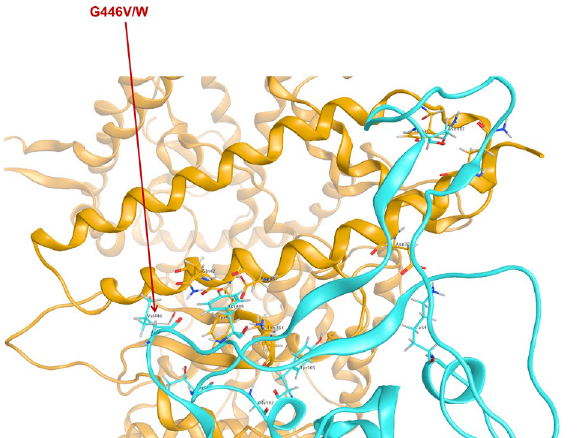
Figure 6. Residue G446 variants in documents from CDC (G446V) and in our prediction (G446W).